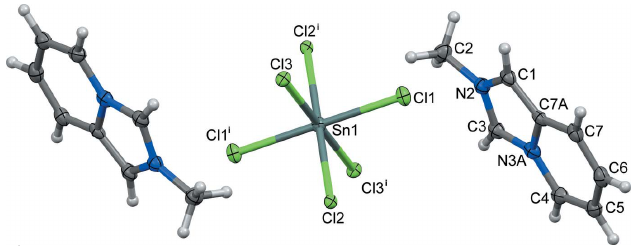
Figure 2 Projection of the crystal packing of (I) on the bc plane showing organic and inorganic sheets alternating parallel to the (101)